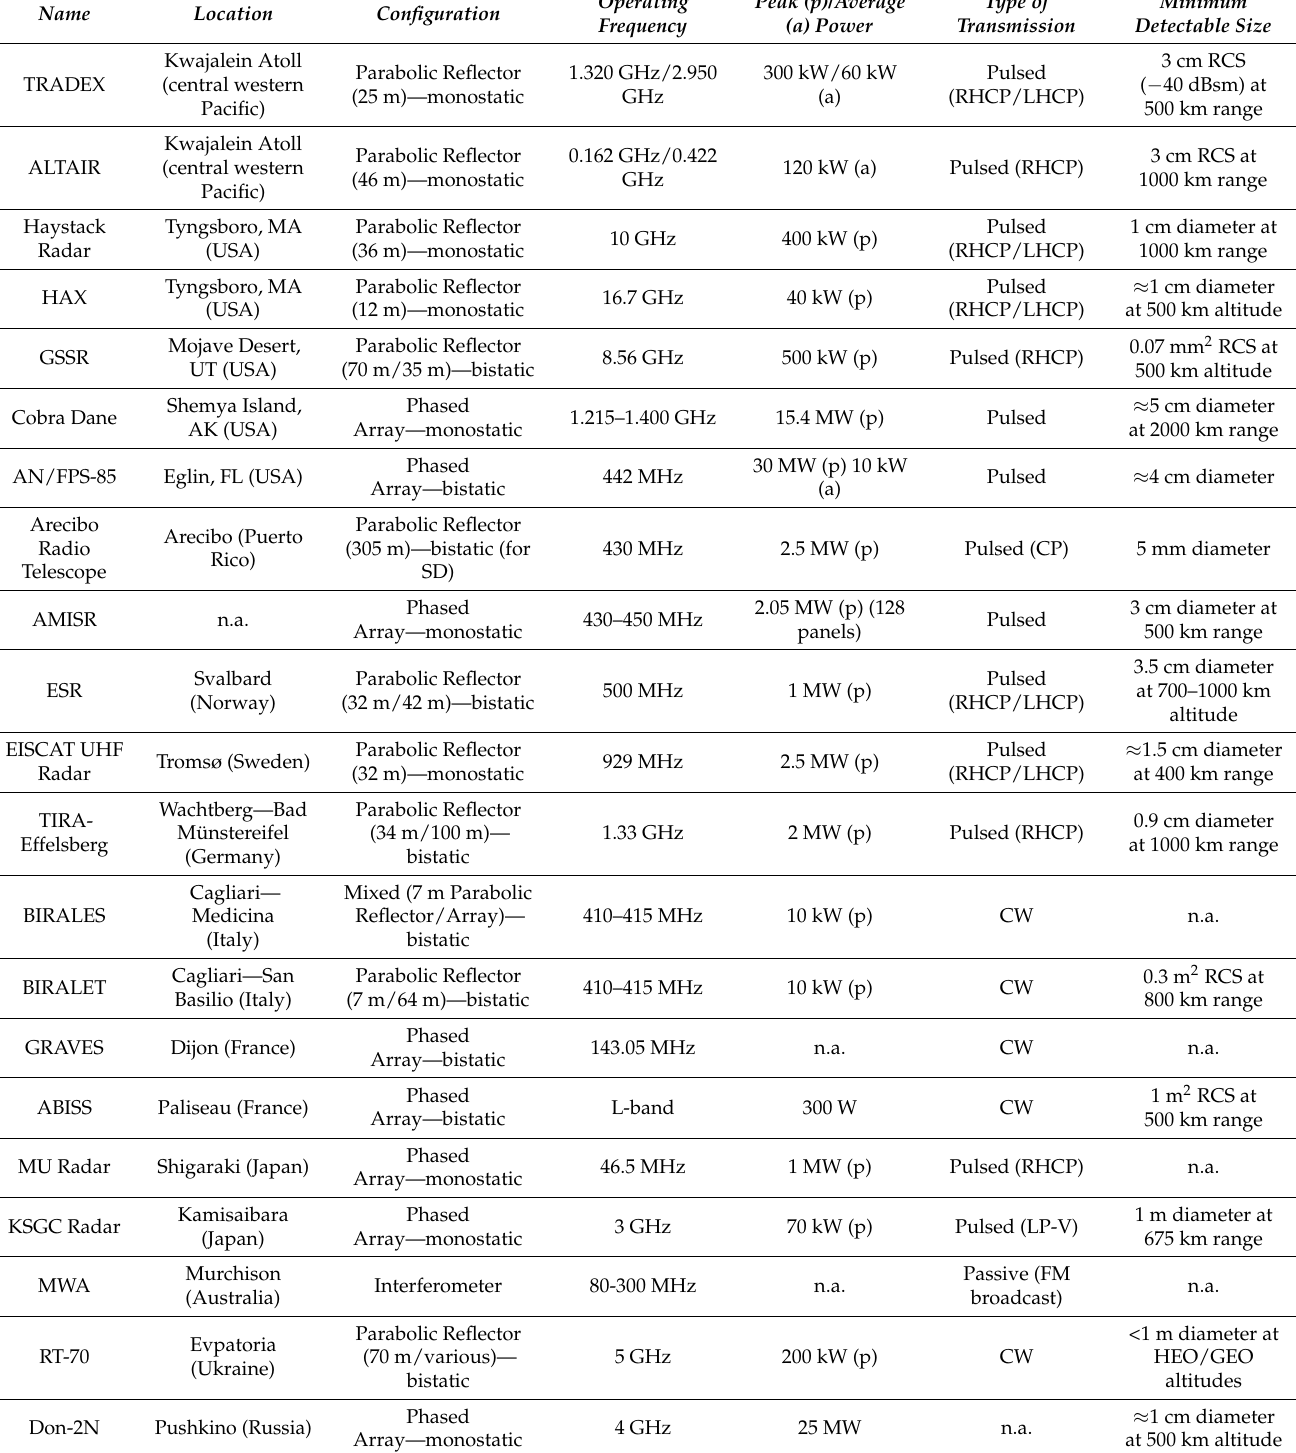
Table 3. Summary table of the analyzed radar